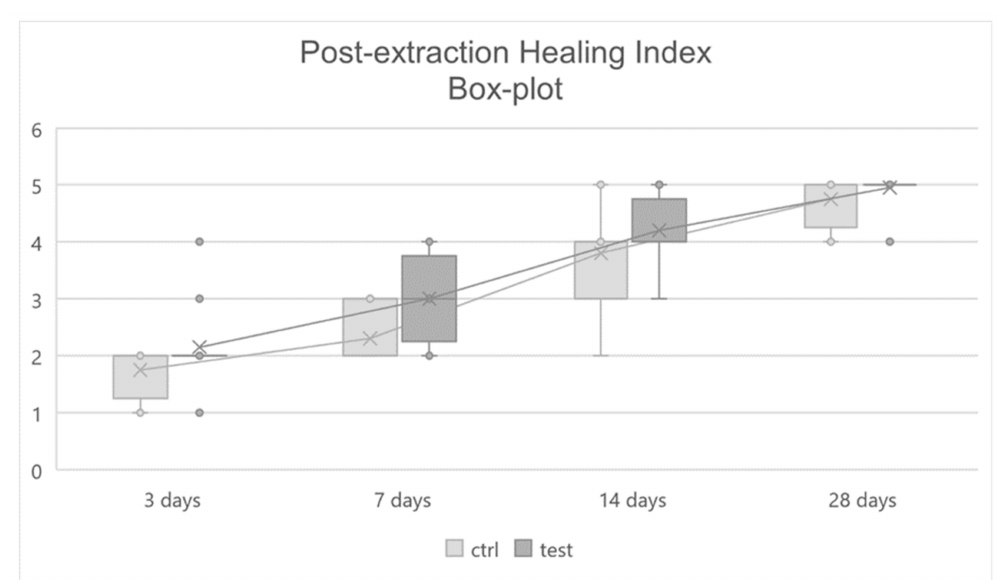
Figure 10. Post-extraction Healing Index